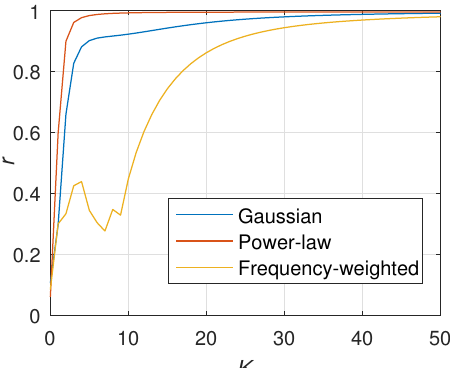
Figure 26. Synchronization progress of different weighting methods in the Iceland 189-node distributed